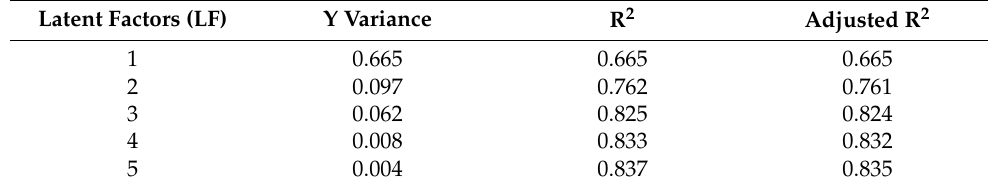
Table 4. Summary of the partial least squares regression (PLSR) modeled results over the